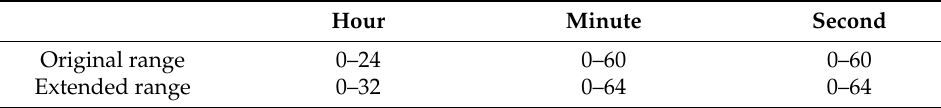
Table 3. Time division scheme.